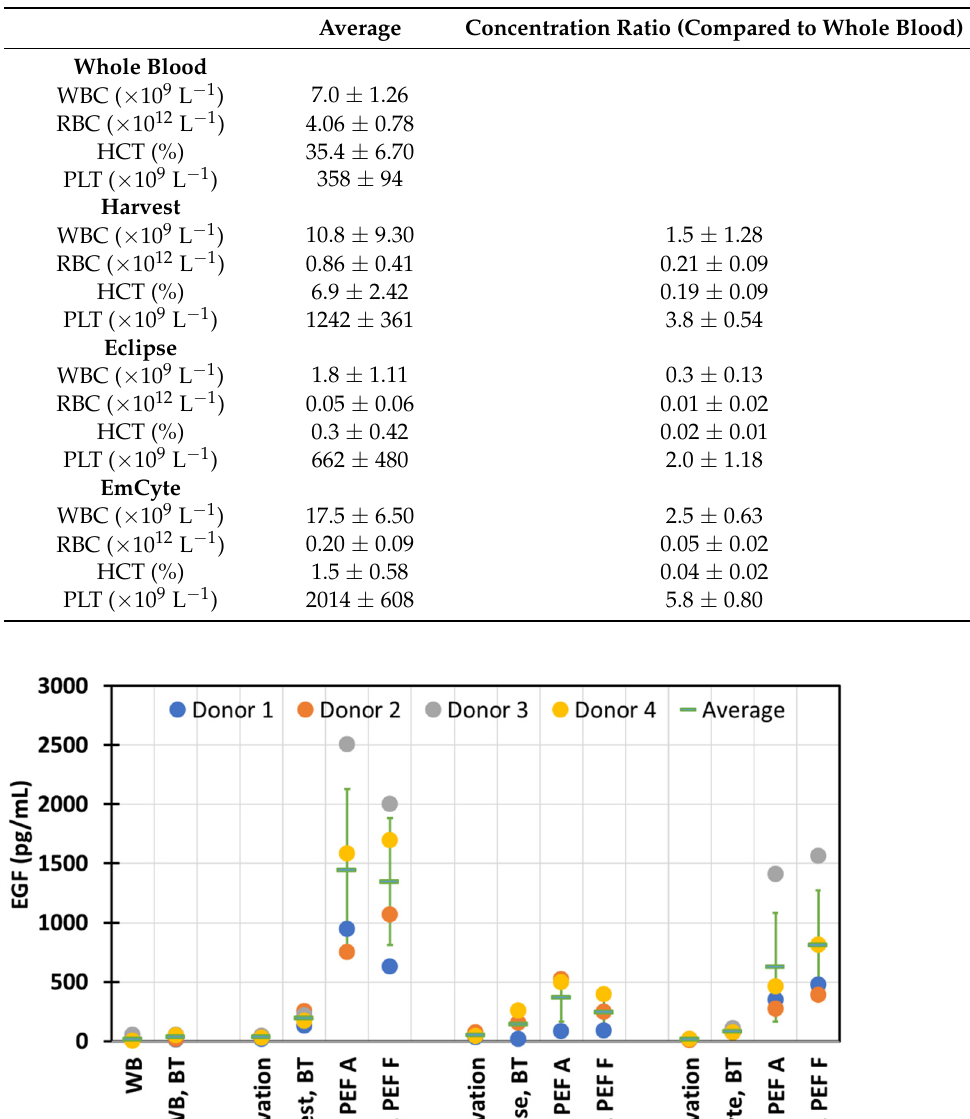
Table 1. Composition of whole blood, Harvest platelet rich plasma (PRP), Eclipse PRP and EmCyte PRP composition averaged for all four donors with uncertainty determined using standard deviation. WBC = white blood cells; RBC = red blood cells; HCT = hematocrit; PLT = platelets.